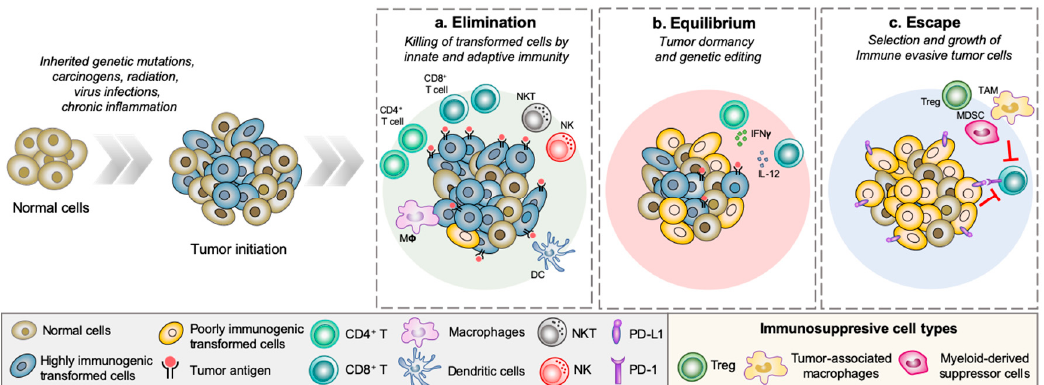
Figure 1. Cancer immunoediting concept–the dual host-protecting and tumor-sculpting actions of the immune system proposed by Dunn et al. [24]. Oncogenic stimuli cause normal cells to undergo transformation and become tumorigenic. Transformed cells are recognized and eradicated by the innate and adaptive immune systems during the elimination phase. In the equilibrium phase, surviving tumor cells continue to adapt to the constant anti-tumor immune pressure. The escape phase is largely associated with the outgrowth of immunoedited tumor cells capable of evading the immune systems through various means; loss of immunogenicity, loss of antigenicity, and/or orchestrating an immunosuppressive microenvironment (i.e., recruitment of immunosuppressive cell types such as regulatory T cells (Treg), tumor-associated macrophages (TAM), and myeloid-derived suppressor cells (MDSC)).